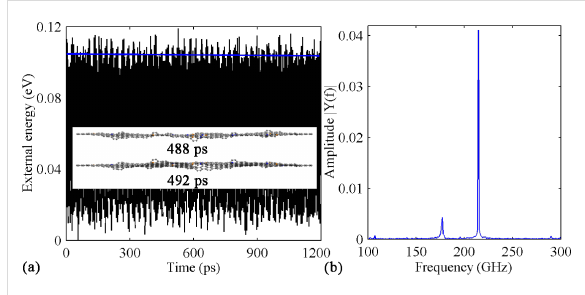
Figure 11: Results of the defective GNR (four vacancies) with 1.20% B- and 1.20% N-dopant. (a) Variation over time of the external energy. The inset shows the sample at the simulation time of 488 and 492 ps. (b) The corresponding frequency